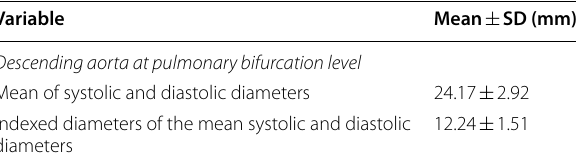
Table 6 Diameters of descending aorta at pulmonary